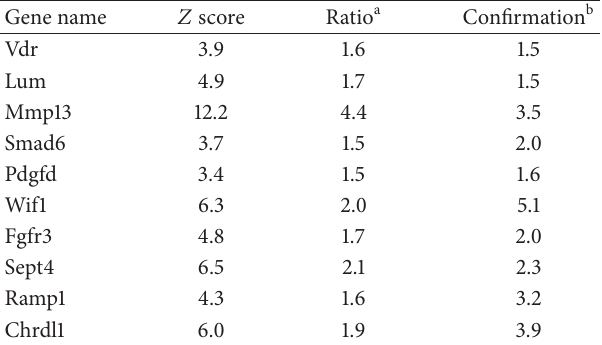
Table 3: Genes expression represented in cell proliferation and differentiation.